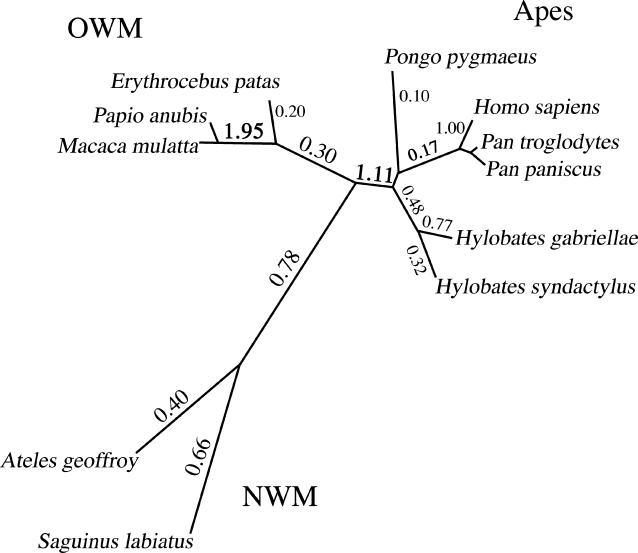
Variable Selective Pressure is Seen Between Lineages for Semen Coagulum Protein TGM4This primate phylogeny shows selective pressure on TGM4 with estimated d
N/d
S ratios indicated on branches. Ratios greater than one are suggestive of either relaxed constraint or positive selection. Ratios are only shown for long branches, those with at least eight substitutions. A null model with a uniform d
N/d
S ratio across all lineages is rejected in favor of these estimates (p = 0.003). Branch lengths are estimated from TGM4 coding sequences. NWM, New World monkeys; OWM, Old World monkeys.